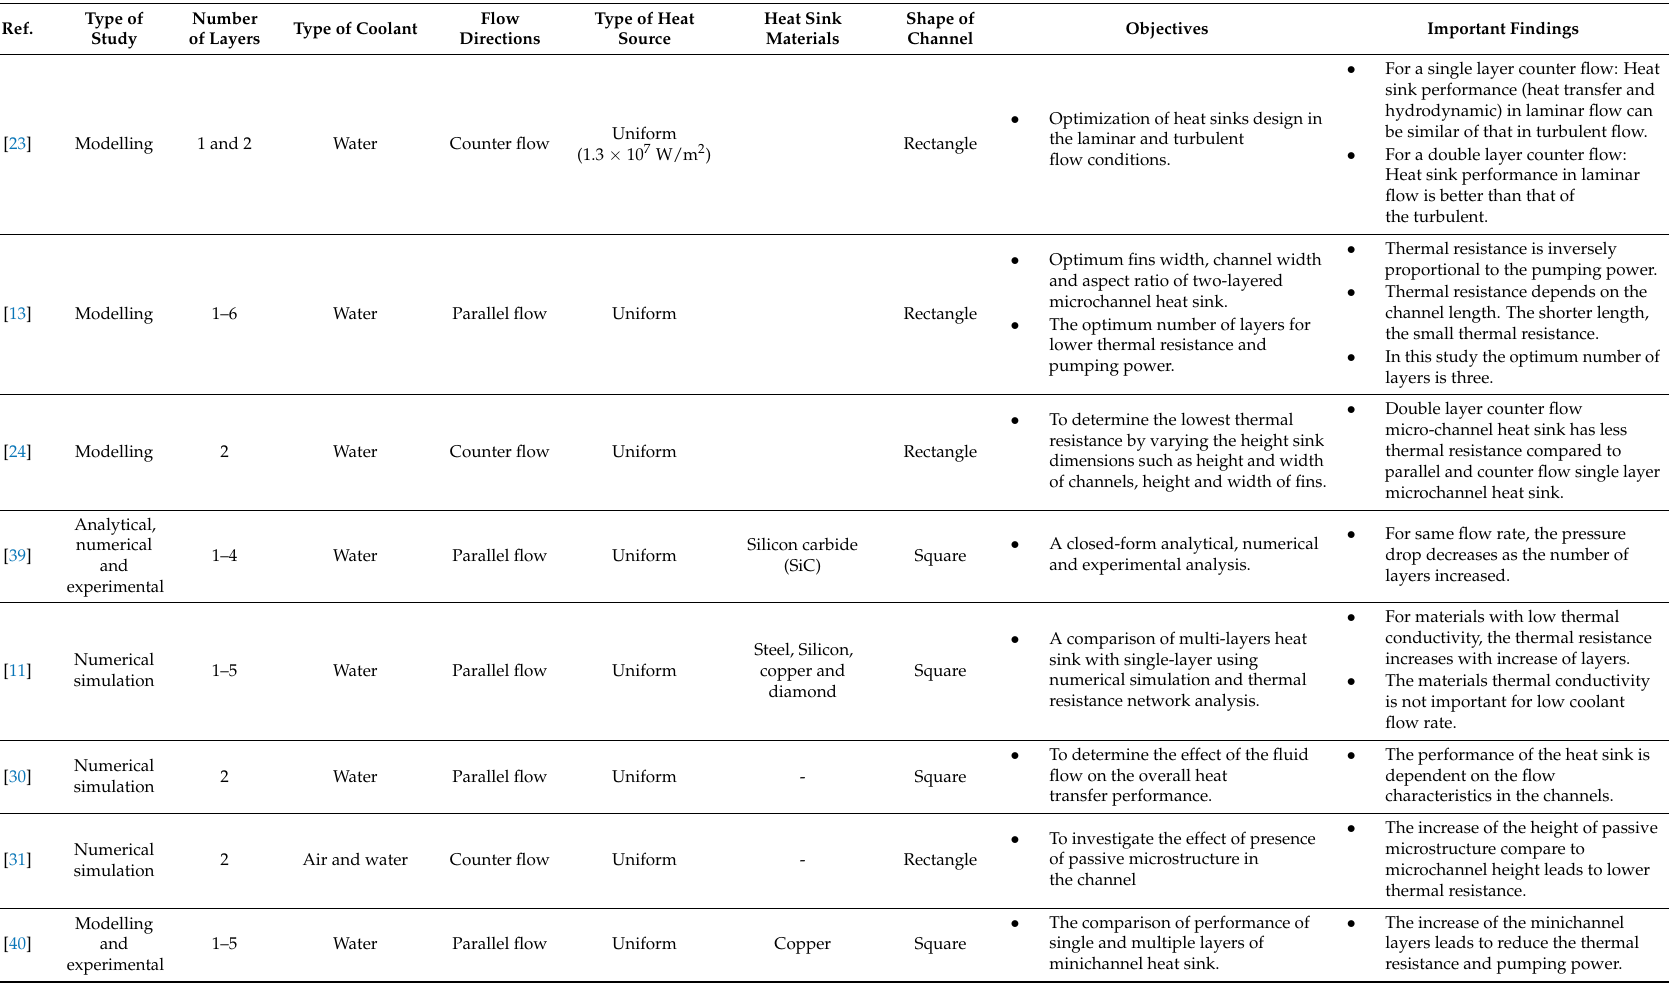
Table 1. Comparative study of different multi-layered microchannel (MLM) heat sink literatures.